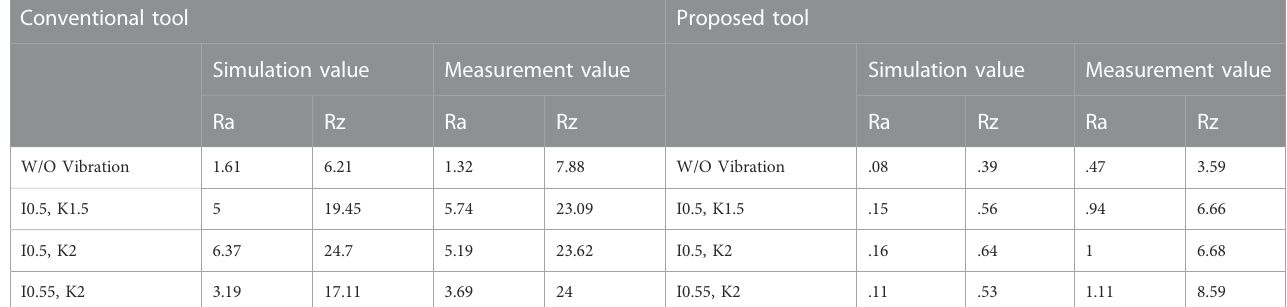
TABLE 2 Summary of surface roughness